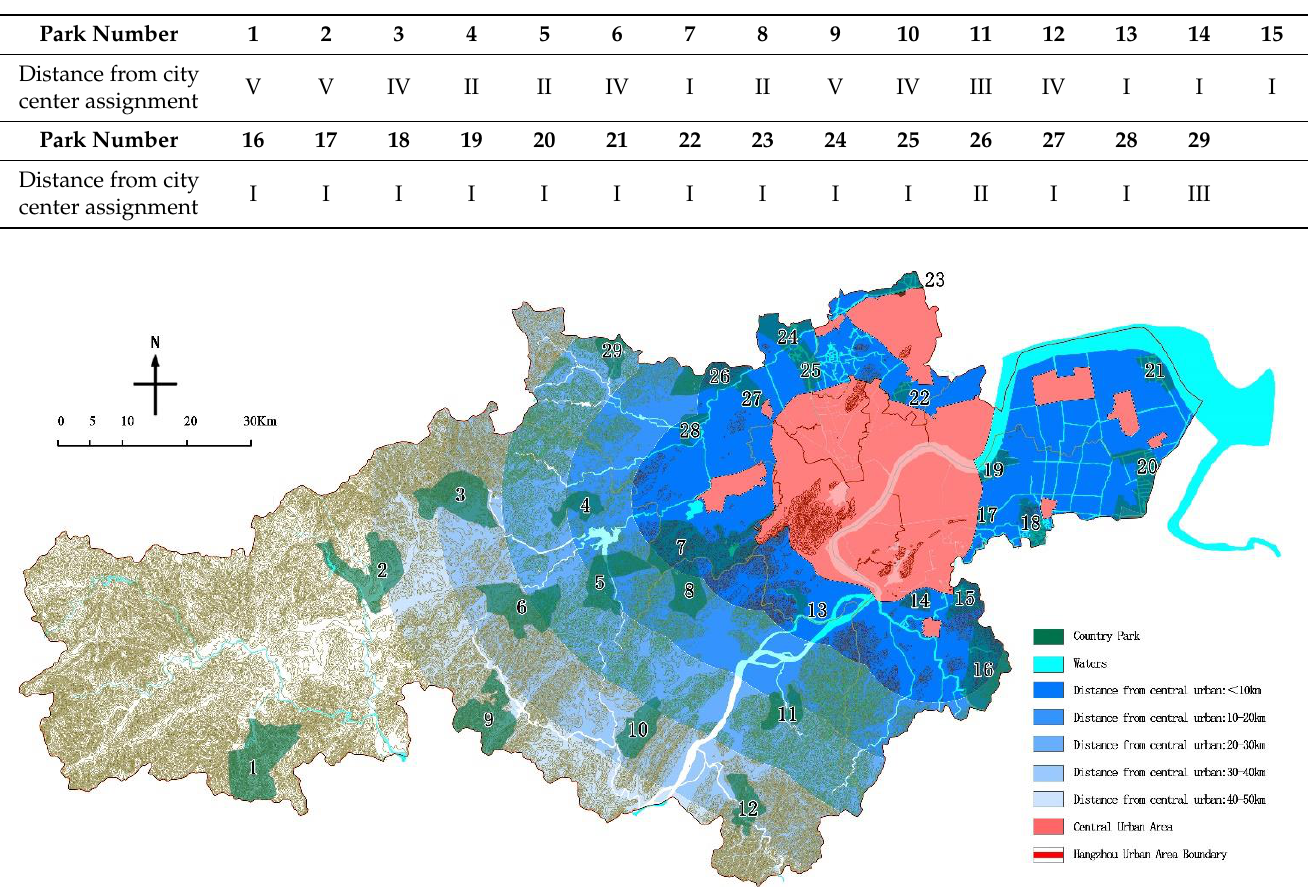
Figure 9. The distance from city center of the country parks.